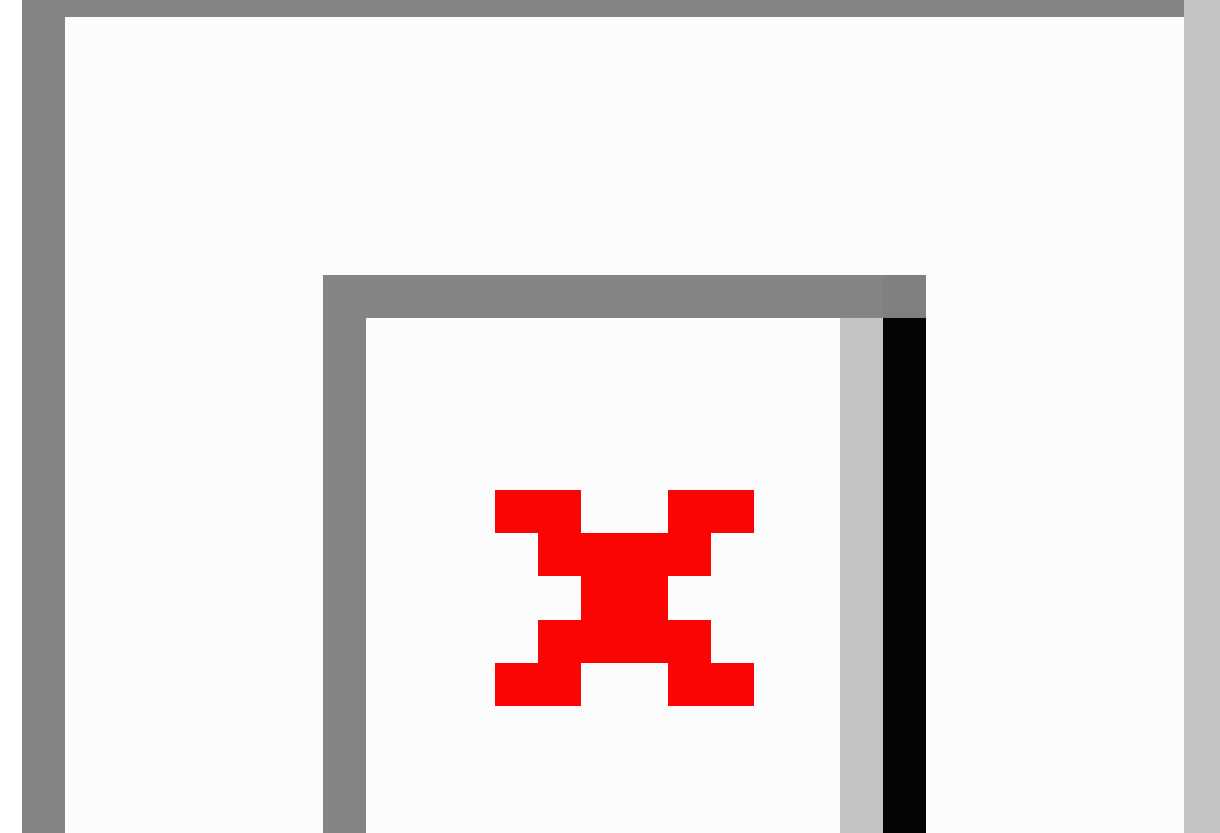
Figure 1. The process of obtaining recommendations for clinical practice guideline (CPG)